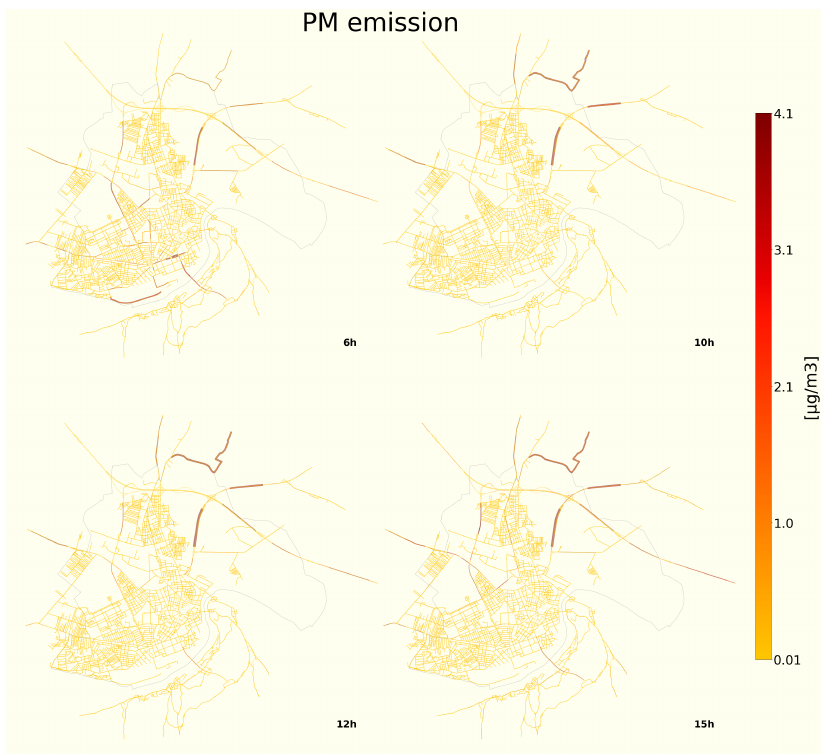
Figure A6. PM emission intensity at different